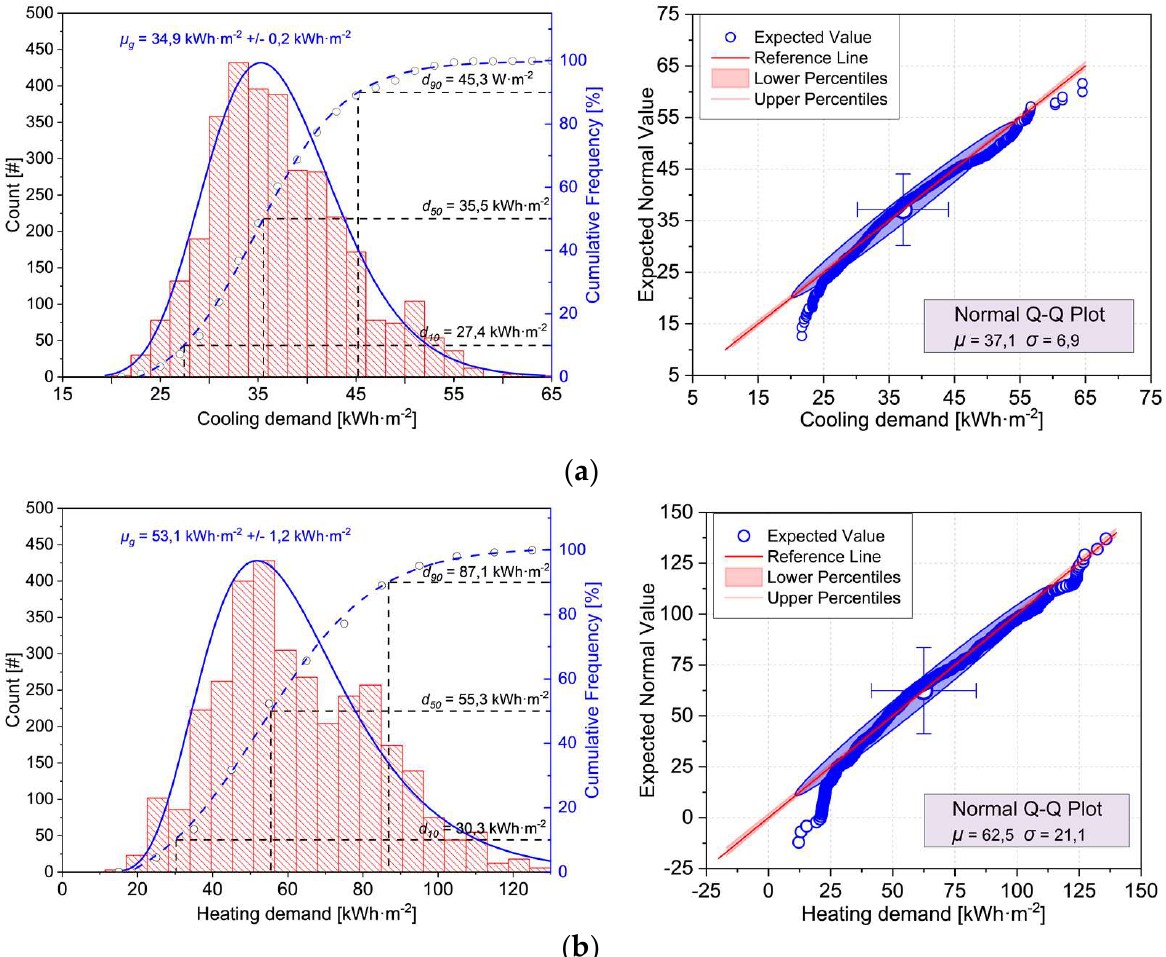
Figure 8. Frequency distribution of cooling and heating demands and normal Q-Q plot: ( a ) cooling demand; ( b ) heating demand.